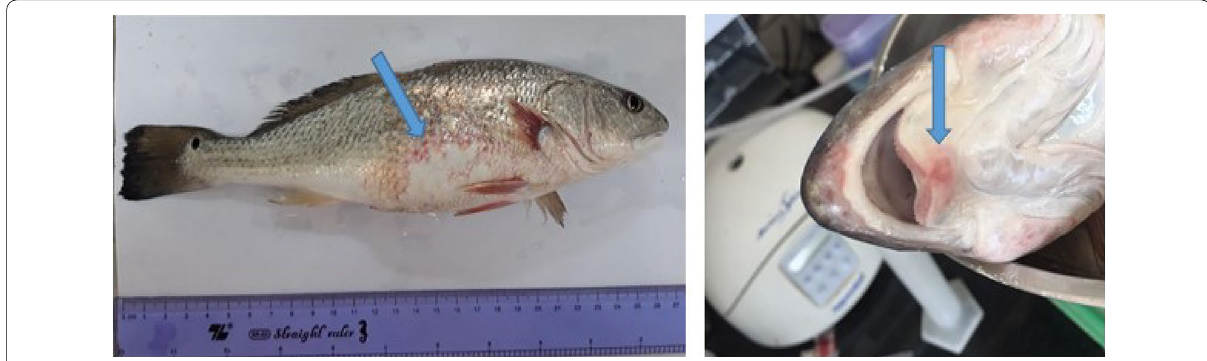
Fig. 1 Sample of Sciaenops ocellatus hemorrhagic